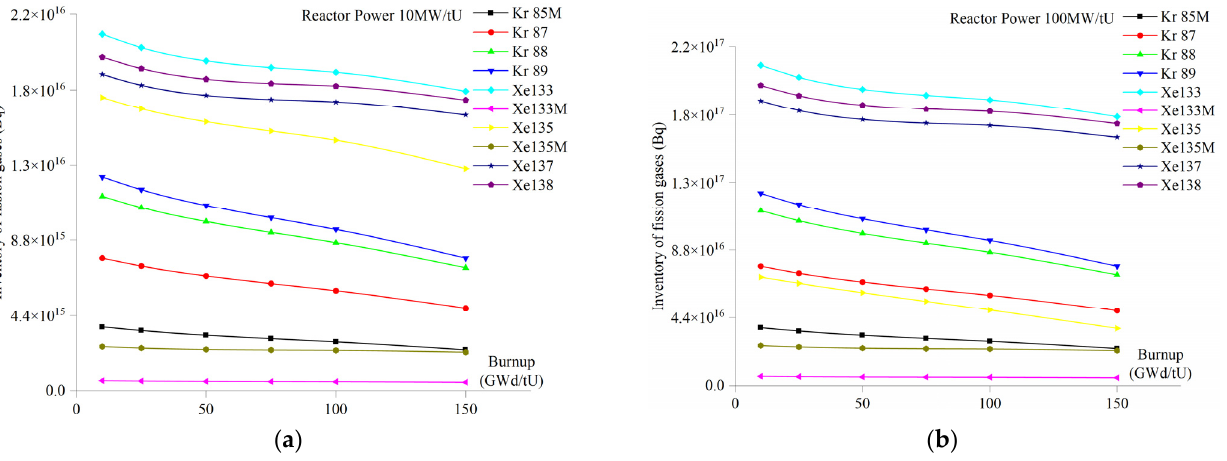
Figure 10. Inventories of fission gas nuclides with increasing burnup under fixed reactor power: ( a ) 10 and ( b ) 100 MW/tU.